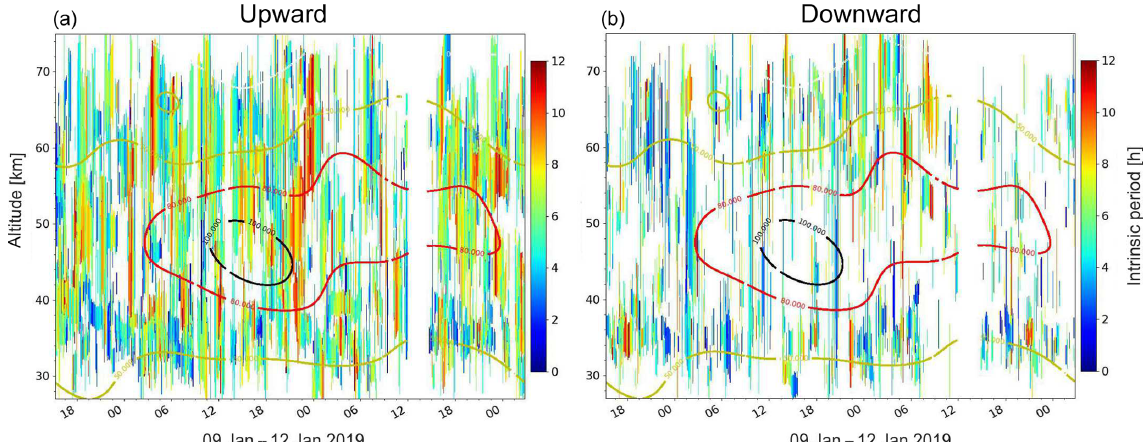
Figure 11. Color-coded bars show the intrinsic period of upward-propagating (a) and downward-propagating (b) waves. The length of the bar is given by the extend of the waves. Contour lines show the background total wind, and the numbers on the contour lines are given in meters per